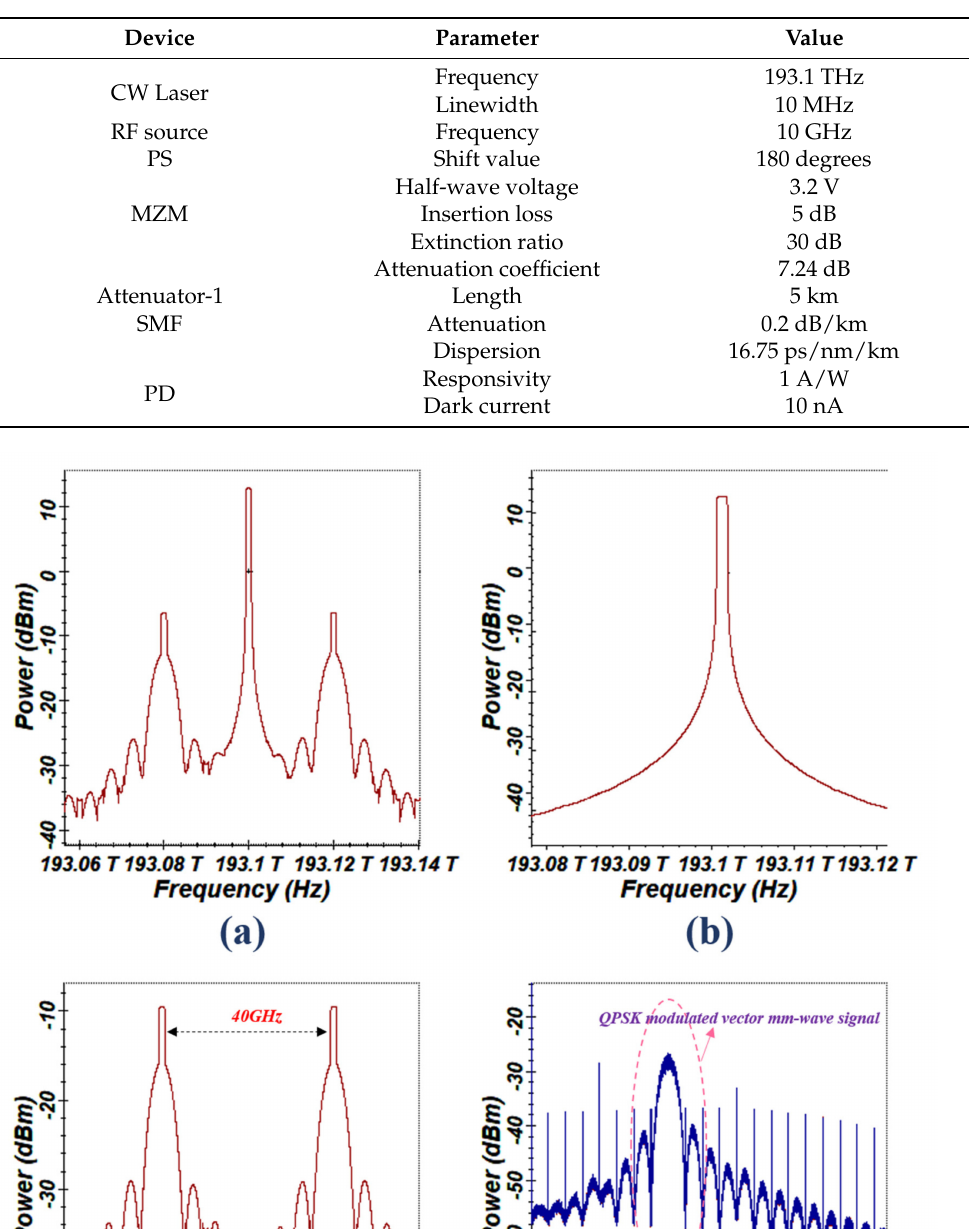
Table 1. All of the used components and their parameters.